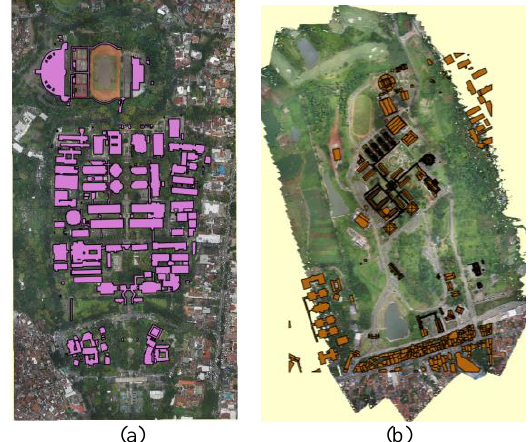
Figure 4. 3D model LoD 2/3 of campus ITB (a) Ganesa and (b)